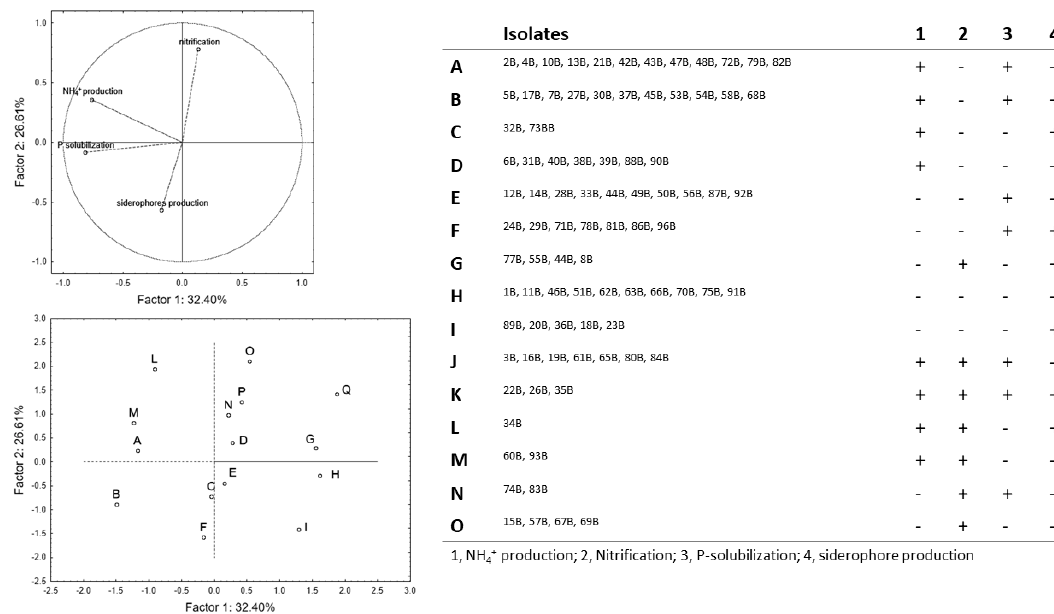
Figure 3. Principal component analysis run on spore-forming bacteria.